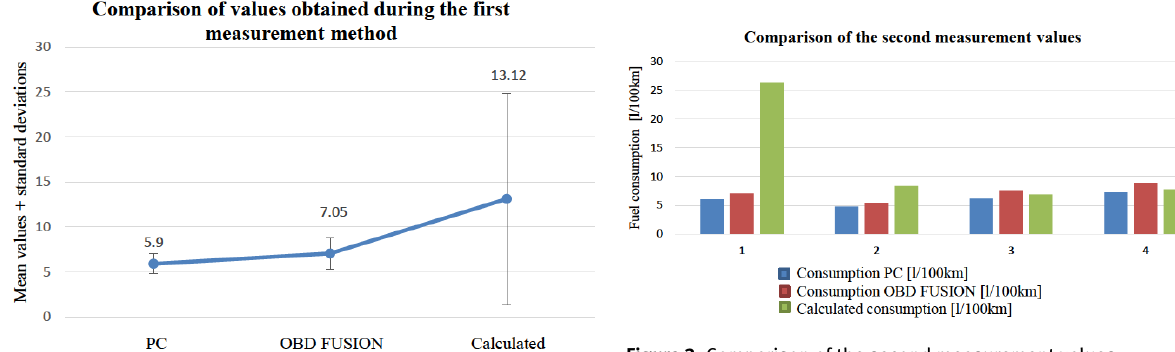
Figure 3: Comparison of the second measurement values Measured values of deviation of the second measure- ment are listed in the following table (Table 9).